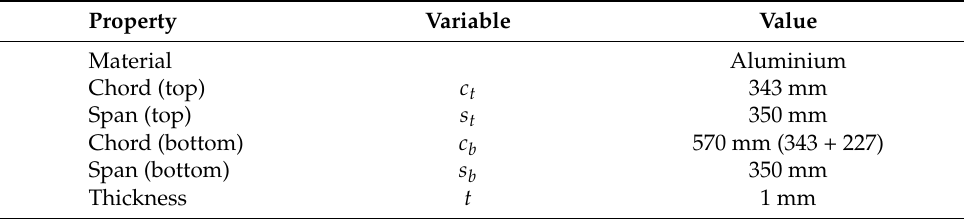
Figure 3. Geometry and coordinate system of the test wing section. Table 1. Material and geometric properties of the